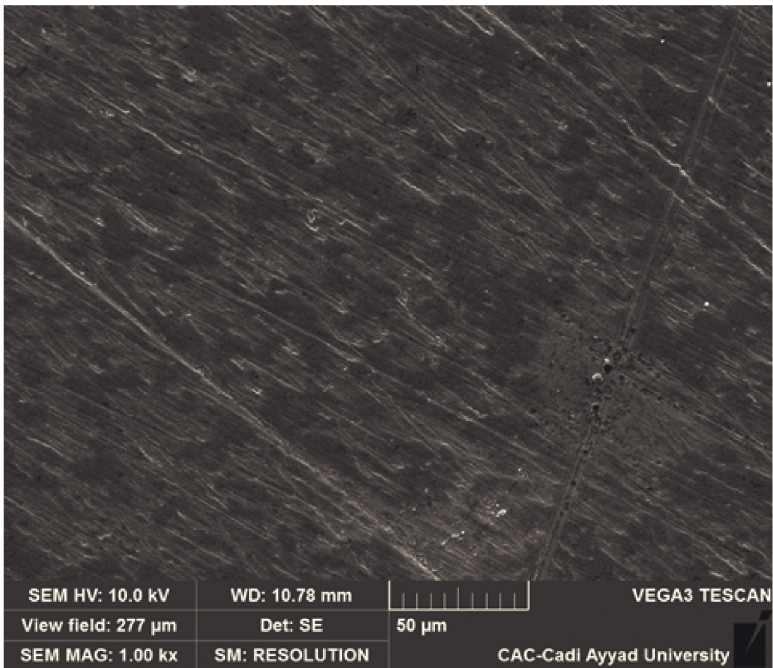
Figure 13: Micrograph of Ti-Cu (2%) freshly polished with emery paper (until 5000